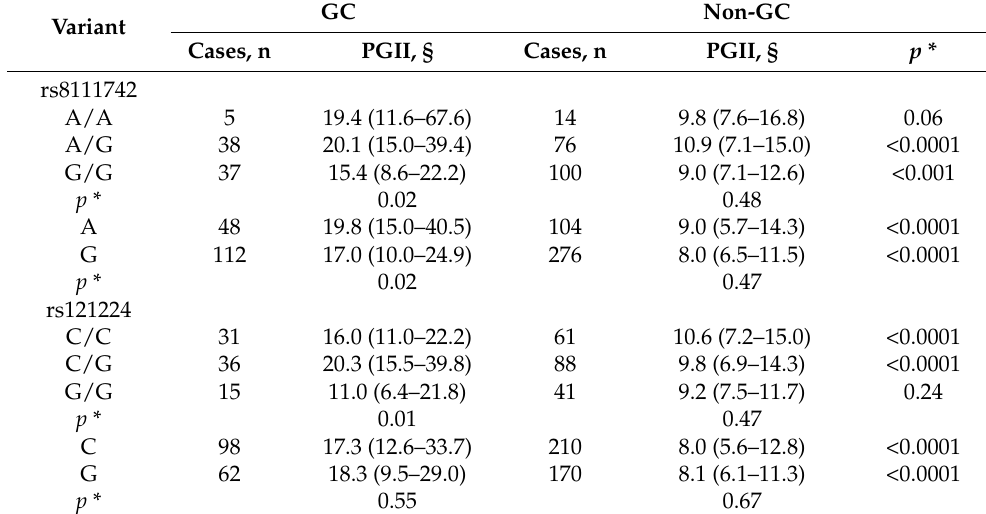
Table 9. Effect of genotype and allele on PGII levels in 80 patients with gastric cancer (GC) and the other 190 study subjects.